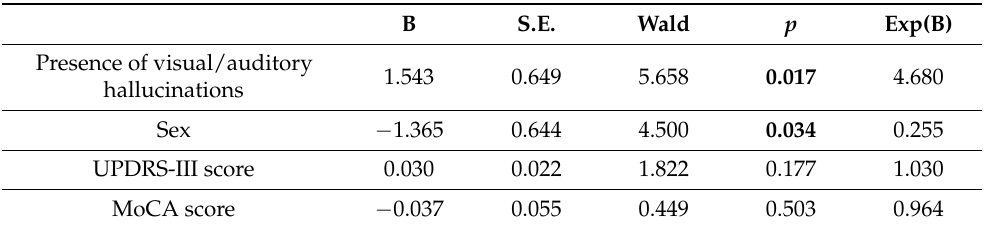
Table 3. Bivariate correlations between olfactory hallucinations versus other hallucinations (visual and acoustic), sex, Unified PD Rating Scale (UPDRS), Montreal Cognitive Assessment (MoCA), levodopa daily dose (LEDD), disease duration, and age. Olfactory Hallucinations p Value Other hallucinations r s = 0.361 p < 0.01 Sex r s = − 0.258 p < 0.01 UPDRS-III score r s = 0.199 p = 0.018 MoCA r s = − 0.161 p = 0.057 LEDD r s = 0.012 p = 0.887 Disease duration r s = 0.004 p = 0.958 Age r s = 0.156 p = 0.065